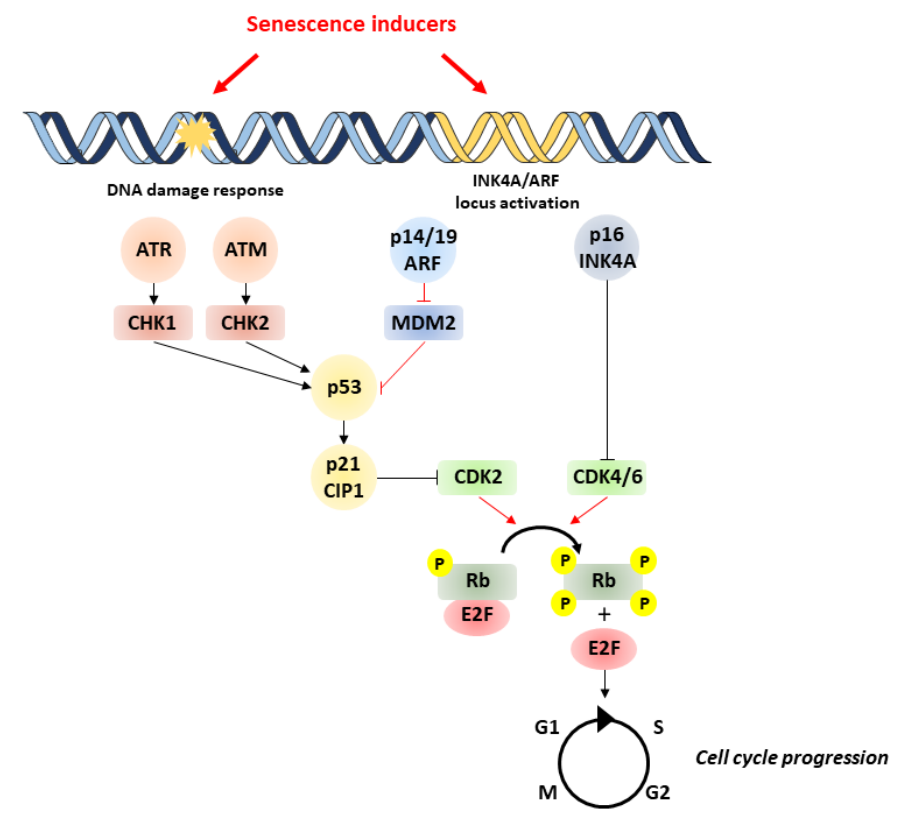
Figure 1. Pathways involved in cell senescence. Senescence is induced by various stressors, which trigger DNA damage and subsequent activation of p53/p21 and p16/pRb pathways. p53 activation is achieved by phosphorylation by ATM/ATR and checkpoint kinases Chk1/Chk2. Likewise, p53 activity can be increased by binding of p14/P19 ARF product of the INK4a locus to MDM2 preventing degradation of p53. p53 can induce senescence by activating p21, which inhibits CDK2, leading to the hypophosphorylation of Rb. In addition to p53, the accumulation of the tumor-suppressor p16 INK4A also leads to cell cycle arrest through the inhibition of CDK4/CDK6 and subsequent hypophosphorylation of Rb. This enables Rb to bind to E2F, inhibiting cell cycle progression. ATM, ataxia-telangiectasia-mutated kinase; ATR, ataxia-telangiectasia- and ATM-Rad3-related kinase; MDM2, murine double minute 2; Rb, retinoblastoma.